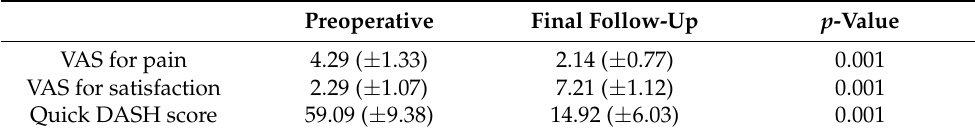
Table 2. Clinical and functional outcomes.